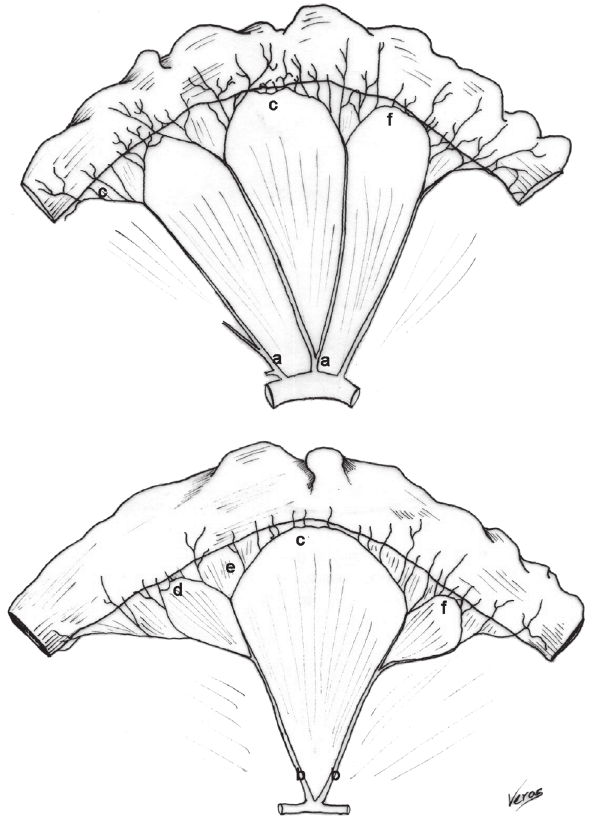
Figures 4-5. Schematic representation of the arcuate jejunal (4) and ileal (5) arteries including: (CrMA) cranial mesenteric artery, (a) pri- mary collateral branches, (b) secondary branches, (c) first-order ar- cuate artery, (d) second-order arcuate artery, (e) straight terminal arteries, (f) dorsal and ventral branches of the straight